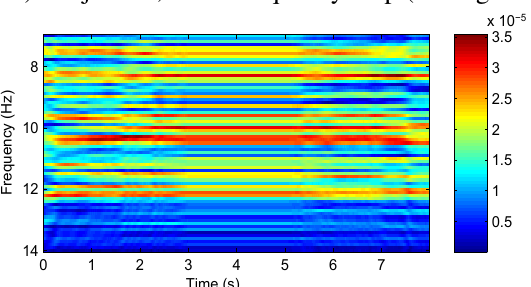
(a2) Surgeon #1, Time-frequency map (pointing task) (b2) Subject #1, Time-frequency map (tracing task)